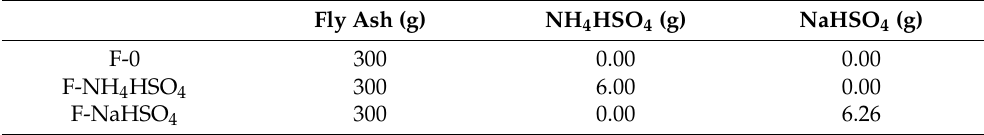
Table 2. Compound ratios used in the preparation of fly ash containing different sulfates. Fly Ash (g)